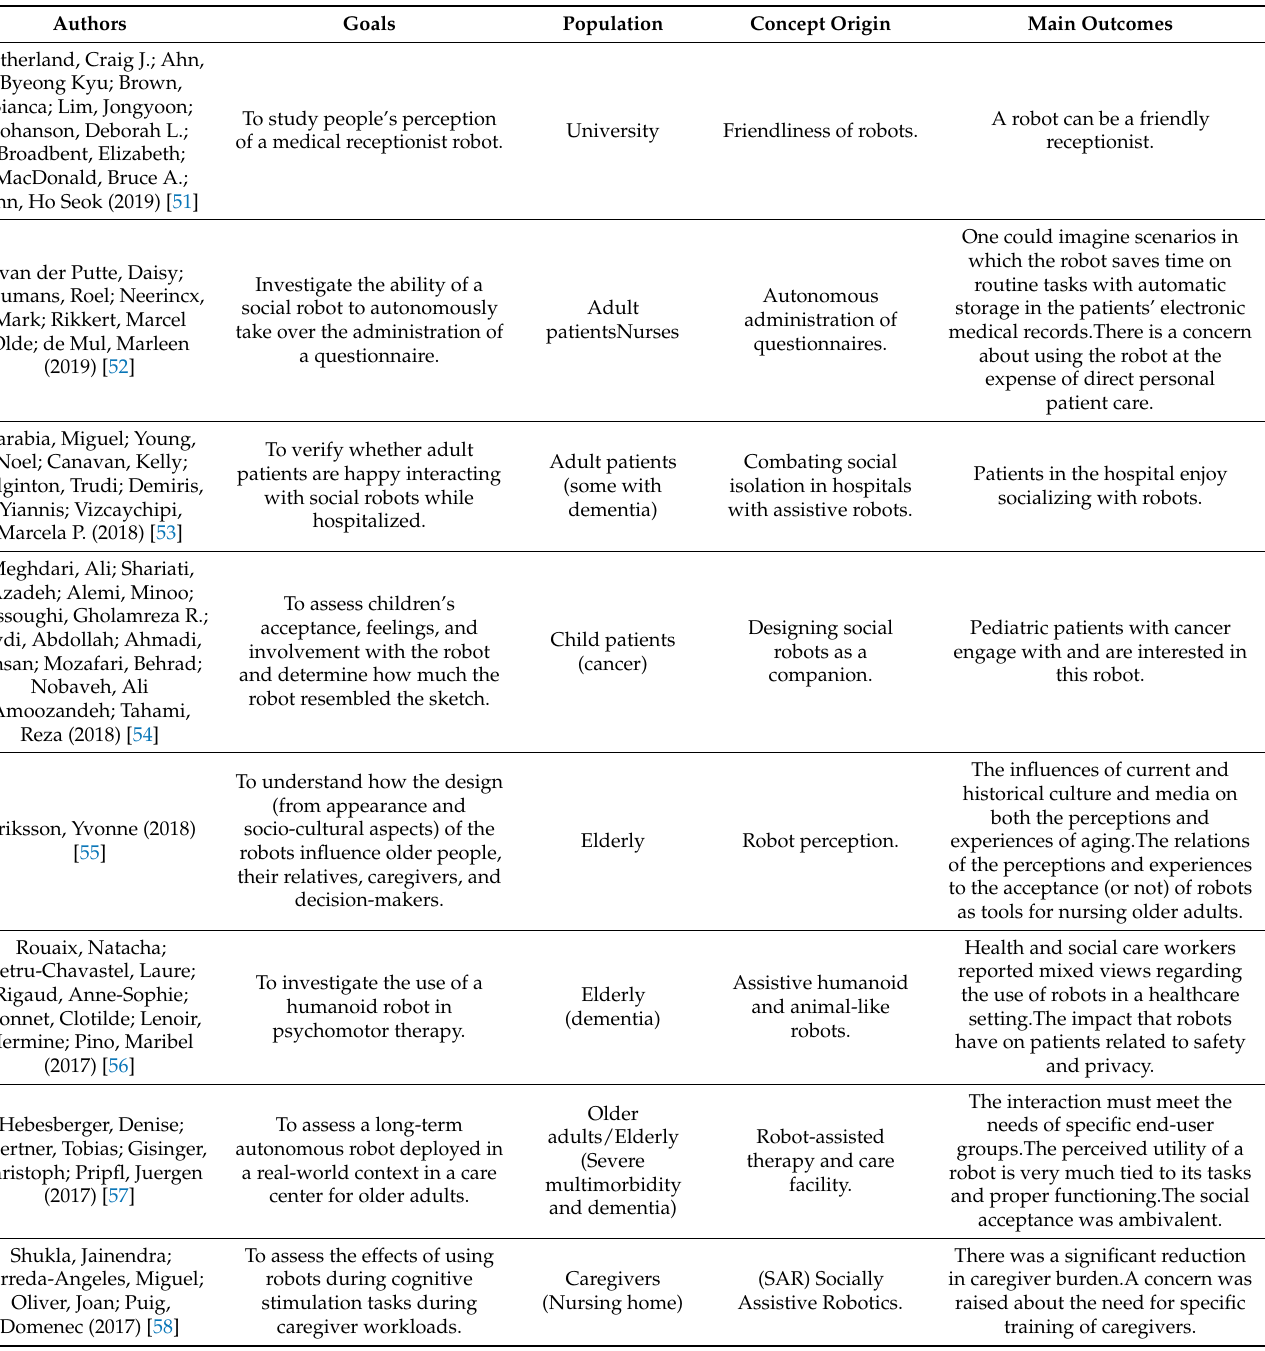
Table 4. Research question 2 (RQ2) on the uses and applications of social